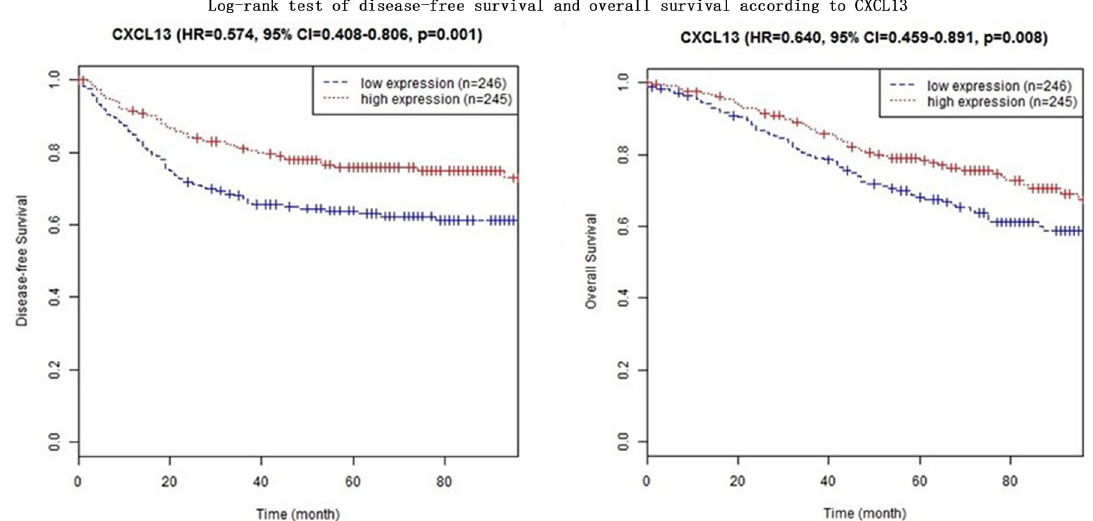
Fig 4. Log-rank test of disease-free survival and overall survival according to CXCL13.